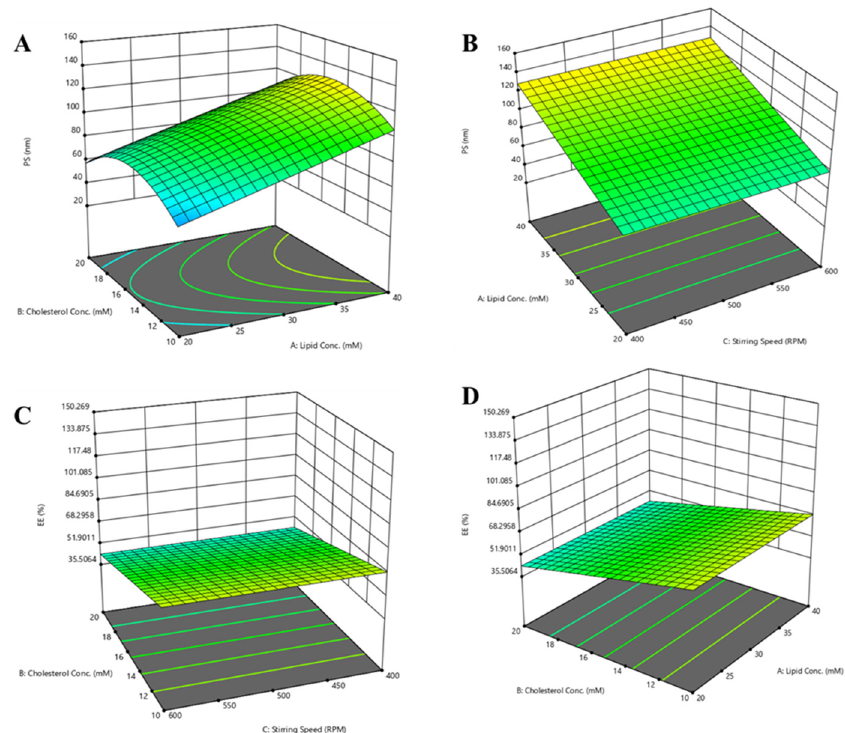
Figure 3. Three-dimensional surface plot for PTH-LPs. ( A ) Effect of lipid concentration and choles- terol concentration on particle size. ( B ) Effect of stirring speed and lipid concentration on particle size. ( C ) Effect of lipid concentration and stirring speed on %EE. ( D ) Effect of lipid concentration and cholesterol concentration on %EE.